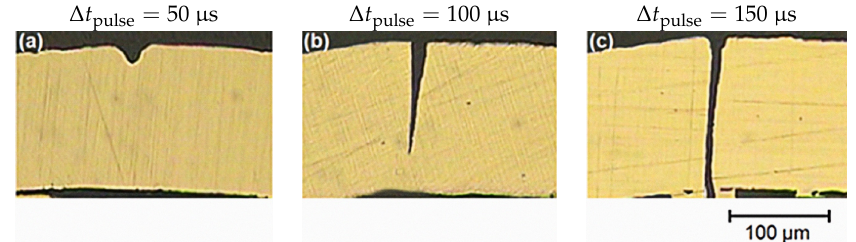
Figure 5. Experimental images of the penetration depth in a single-pulsed laser drilling test from [10]. Reprinted from [13], Copyright (2020), with permission from Elsevier under License Number 4835890957650.